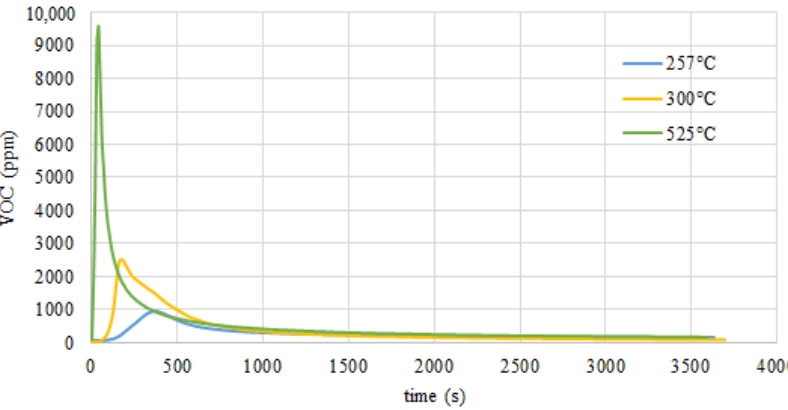
Figure 16. Volatile organic content (VOC) emission in ppm of the Miscanthus torrefaction process in an electric oven in a CO 2 atmosphere.